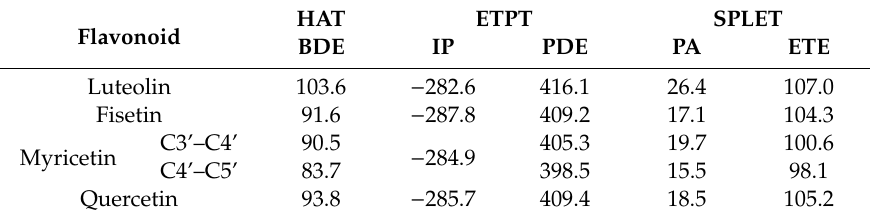
Table 8. Enthalpies of diradical formation mechanisms [kcal /